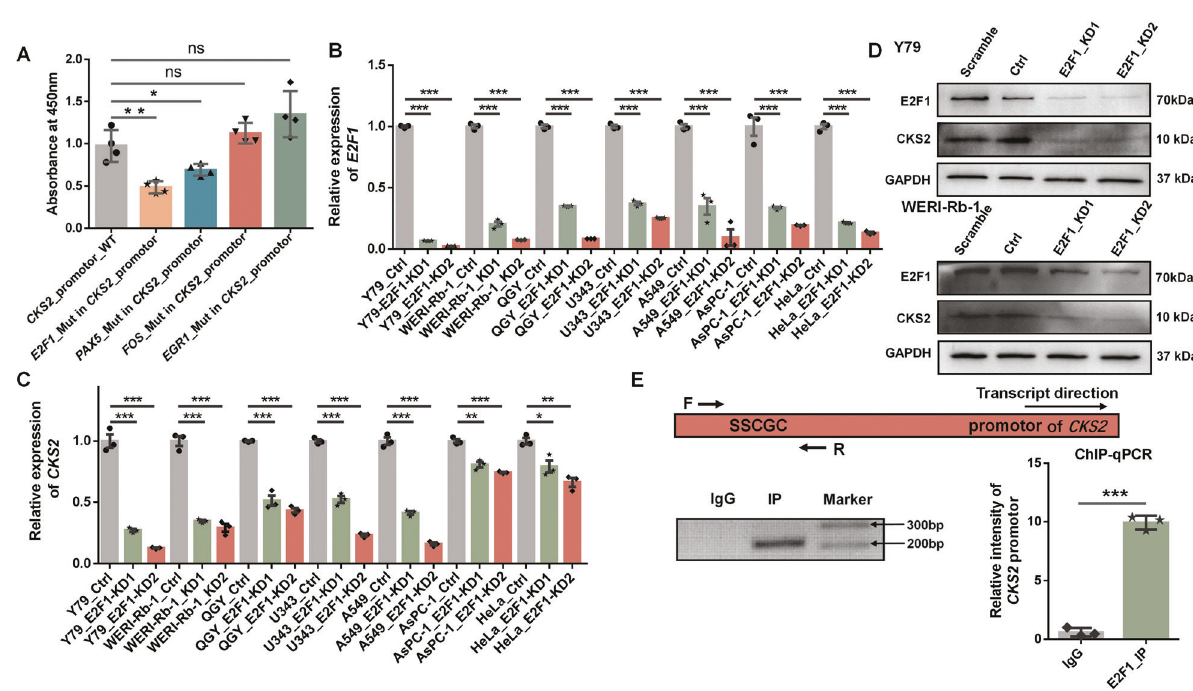
Fig. 3 E2F1 binds to CKS2 promotor and regulates its expression. A Luciferase activity of CKS2 ’ s wild-type (WT) and mutated (Mut) promotors in Y79 cells. The mutation was achieved by replacing a palindromic sequence to a speci fi c TF potential binding site. B Knockdown of E2F1 in Y79, WERI-Rb-1, QGY, U343, A549, AsPC-1 and HeLa human cells evaluated by qRT-PCR. GAPDH served as the internal control. C Validation of CKS2 expression after E2F1 knockdown in Y79, WERI-Rb-1, QGY, U343, A549, AsPC-1 and HeLa human cells evaluated by qRT- PCR. GAPDH served as the internal control. D Western blotting showed that the protein expression of CKS2 was signi fi cantly reduced in E2F1 - KD Y79 (up panel) and WERI-Rb-1 (down panel) cells. GAPDH served as the internal control. E E2F1 binding to the promotor region of CKS2 was evaluated by ChIP-PCR and ChIP-qPCR in Y79 cells. The black arrow represents the transcription direction. The ChIP-PCR and ChIP-qPCR primer pairs (F and R, forward and reverse, respectively) were designed spanning the “ SSCGC ” motif (S = G or C) within the ChIP-seq peak region. The same amount of DNA was applied for ChIP-PCR (left panel) and ChIP-qPCR (right panel). *** P < 0.001; ** P < 0.01; * P < 0.05, by two- tailed t